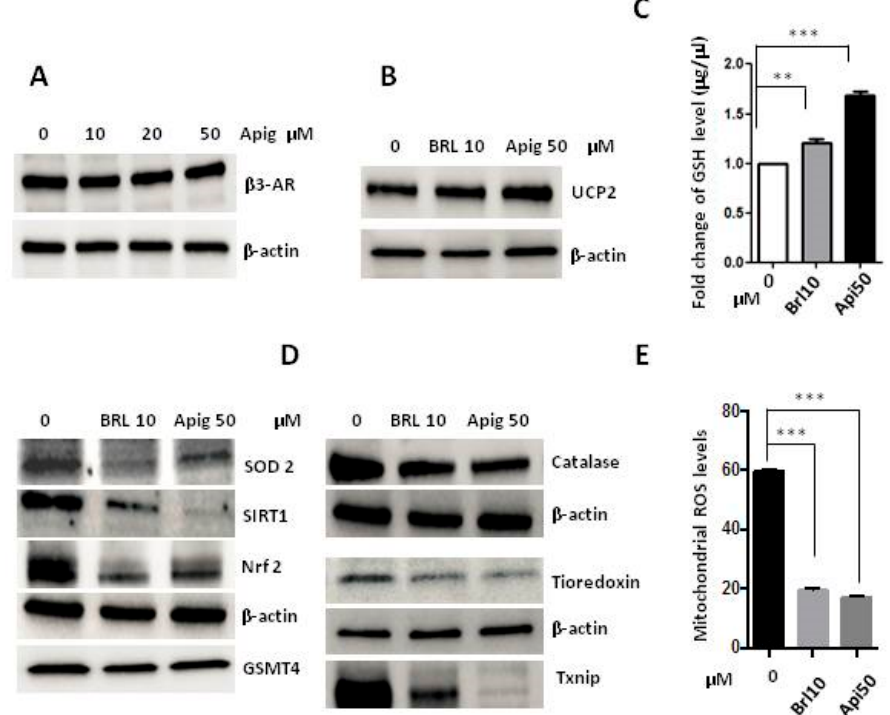
Figure 4. ( A ) Western Blot analysis of β 3-AR expression after 24 h of treatment with apigenin